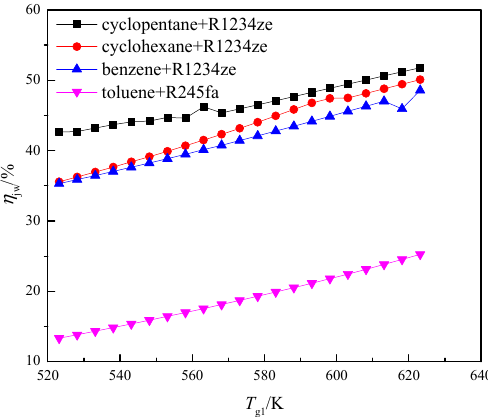
Figure 13. Effects of T g1 on the heat utilization ratio of the jacket cooling water.